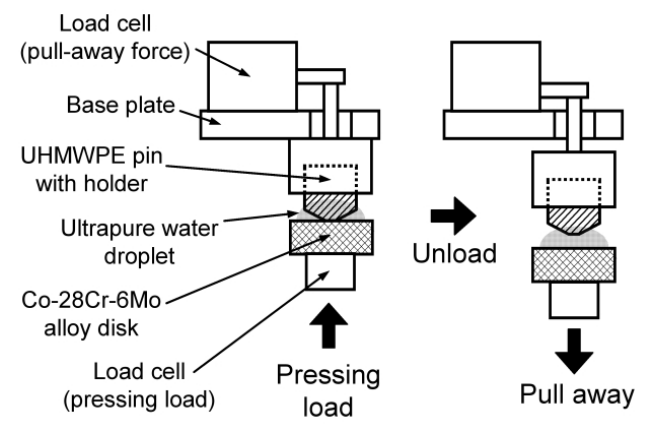
Fig. 4 A schematic drawing of the apparatus and the procedure for measuring the pull-away force between UHMWPE and the Co-28Cr-6Mo alloy.